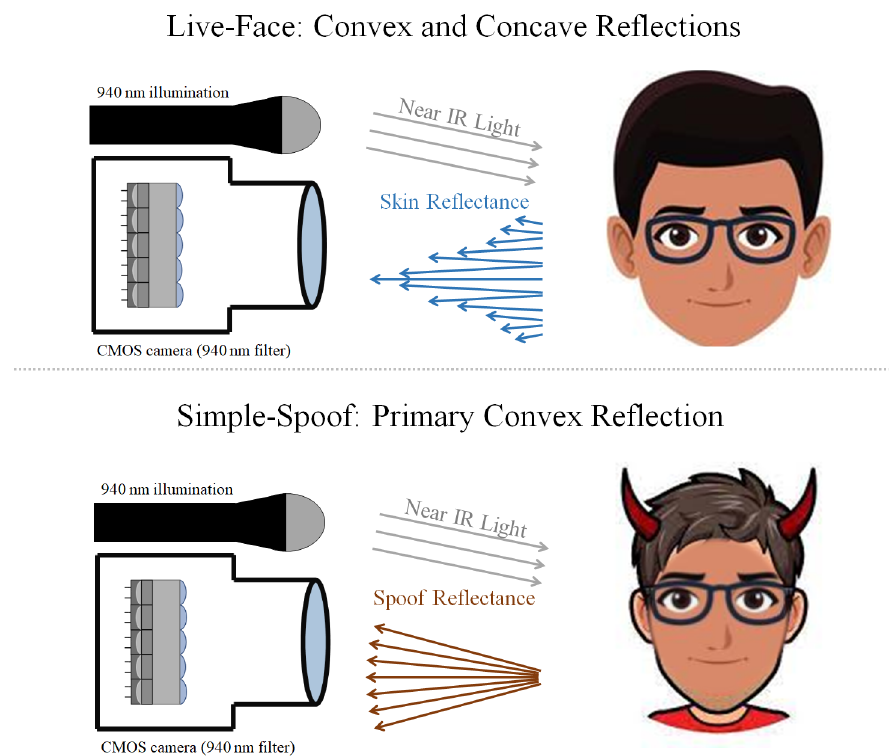
Figure 2. Using material spectroscopy principles for liveliness. Live people have complex geometry with highly variant reflectance patterns. Simple spoofs conversely have relatively uniform reflectance patterns. These patterns can be classified using texture